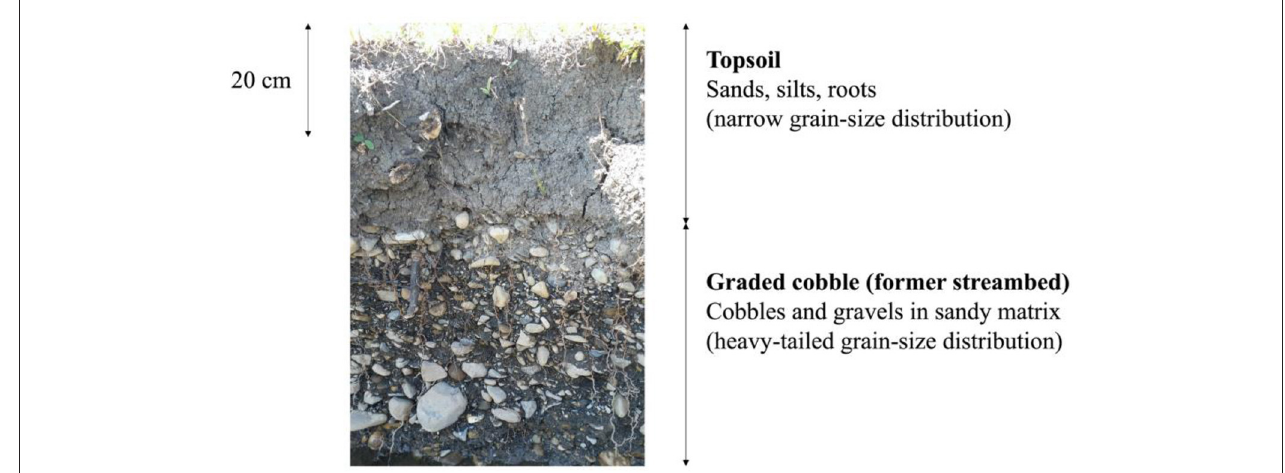
FIGURE 2 | Exposed floodplain cross-section used to inform model